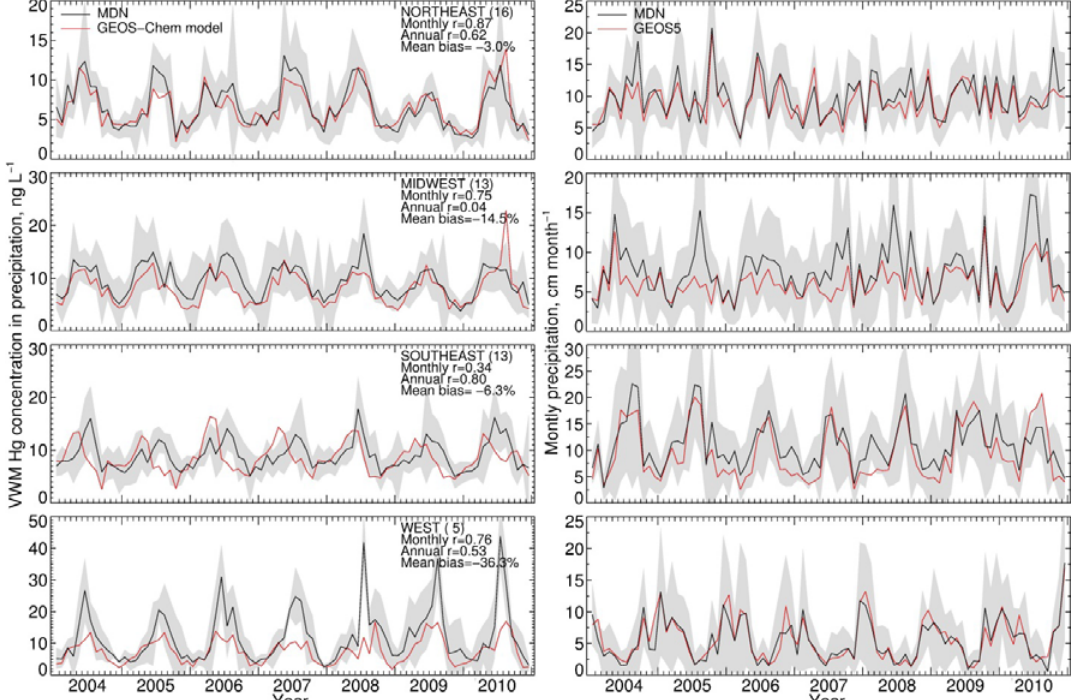
Figure 2. Monthly volume-weighted mean (VWM) Hg concentrations in precipitation ( left ) and precipitation depths ( right ) from Mercury Deposition Network (MDN) observations and the GEOS-Chem BASE simulation (constant anthropogenic emissions) for 2004–2010. The grey shaded area shows the ± standard deviation envelope for the MDN